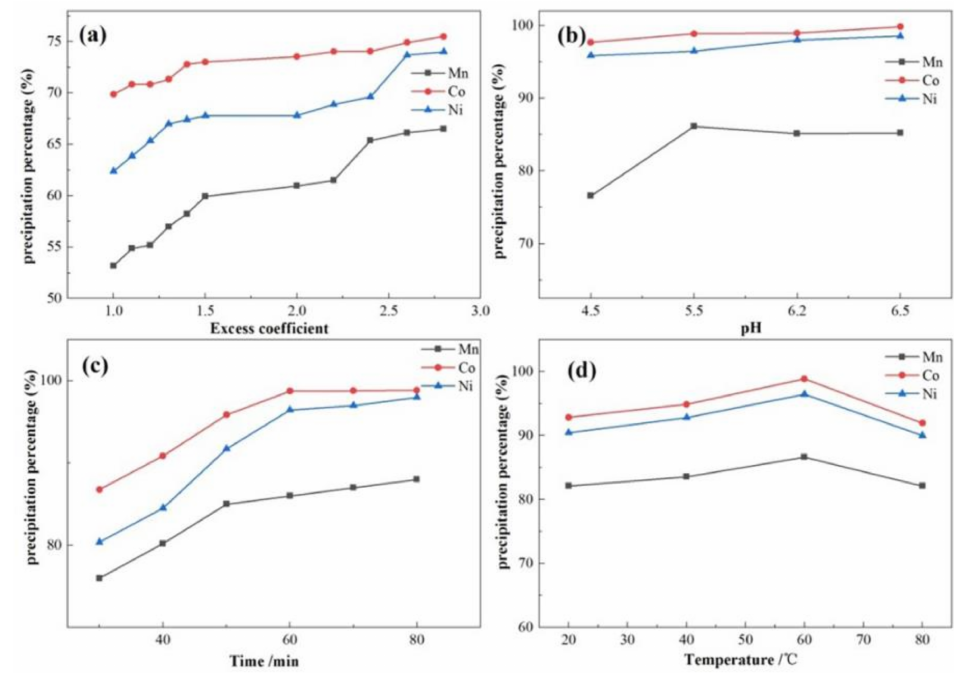
Figure 2. Impurities precipitation percentage under different conditions.; ( a ) Excess coefficient; ( b ) pH; ( c ) Time; ( d )